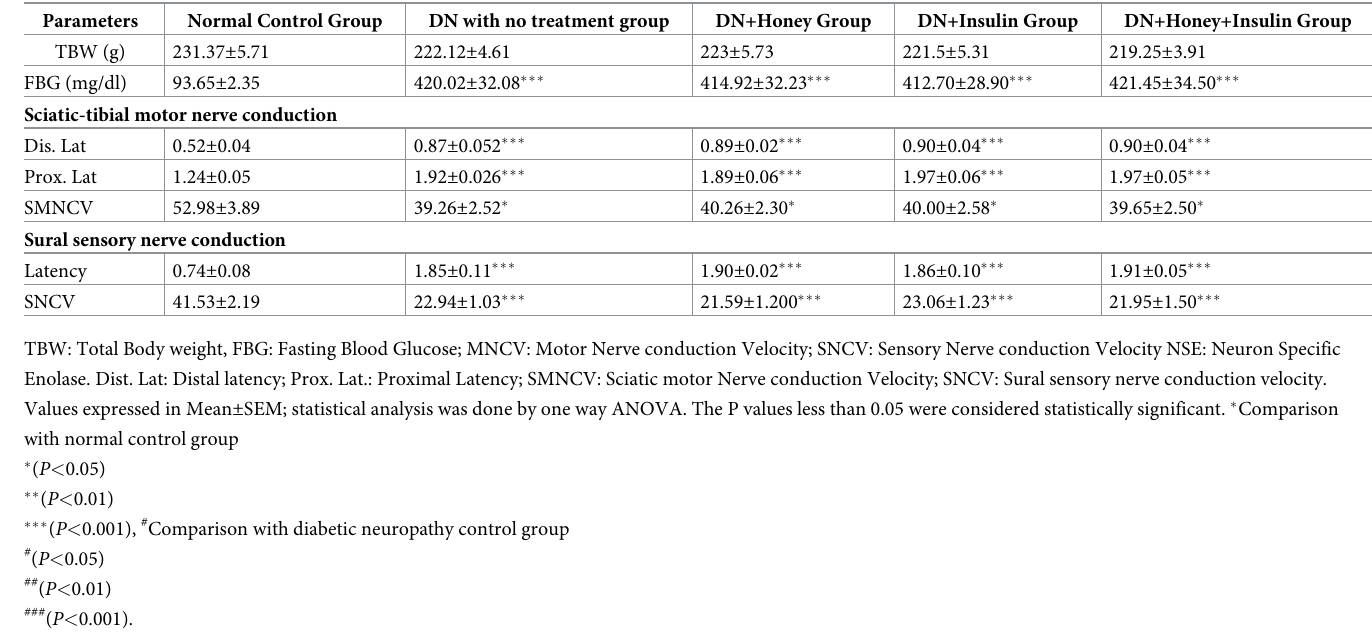
Table 1. Comparison of TBW, FBG and nerve conduction study parameters in all the groups at the baseline (before the intervention). Parameters